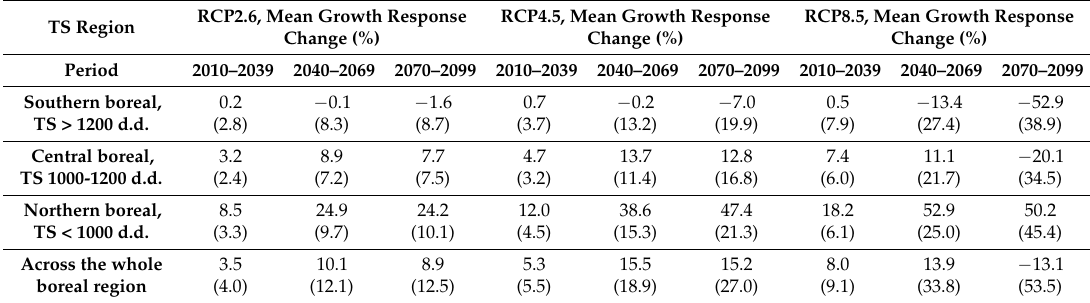
Table 6. Mean change (%) in the diameter growth (% of that under the current climate) of all tree species on upland forest sites under minor (RCP2.6), moderate (RCP4.5), and severe (RCP8.5) climate change scenarios for three 30-year calculation periods for the current temperature sum (TS) regions representing southern, central, and boreal regions. The numbers in parentheses indicate the standard deviation of growth change. If drained peatland sites were included in these calculations, the positive responses of growth would have been slightly higher and the negative ones lower (see, e.g., Table 5). TS Region RCP2.6, Mean Growth Response RCP4.5, Mean Growth Response RCP8.5, Mean Growth Response TS Region Change (%) Change (%) Change (%) Period Southern boreal, TS > 1200 d.d. Central boreal, TS 1000-1200